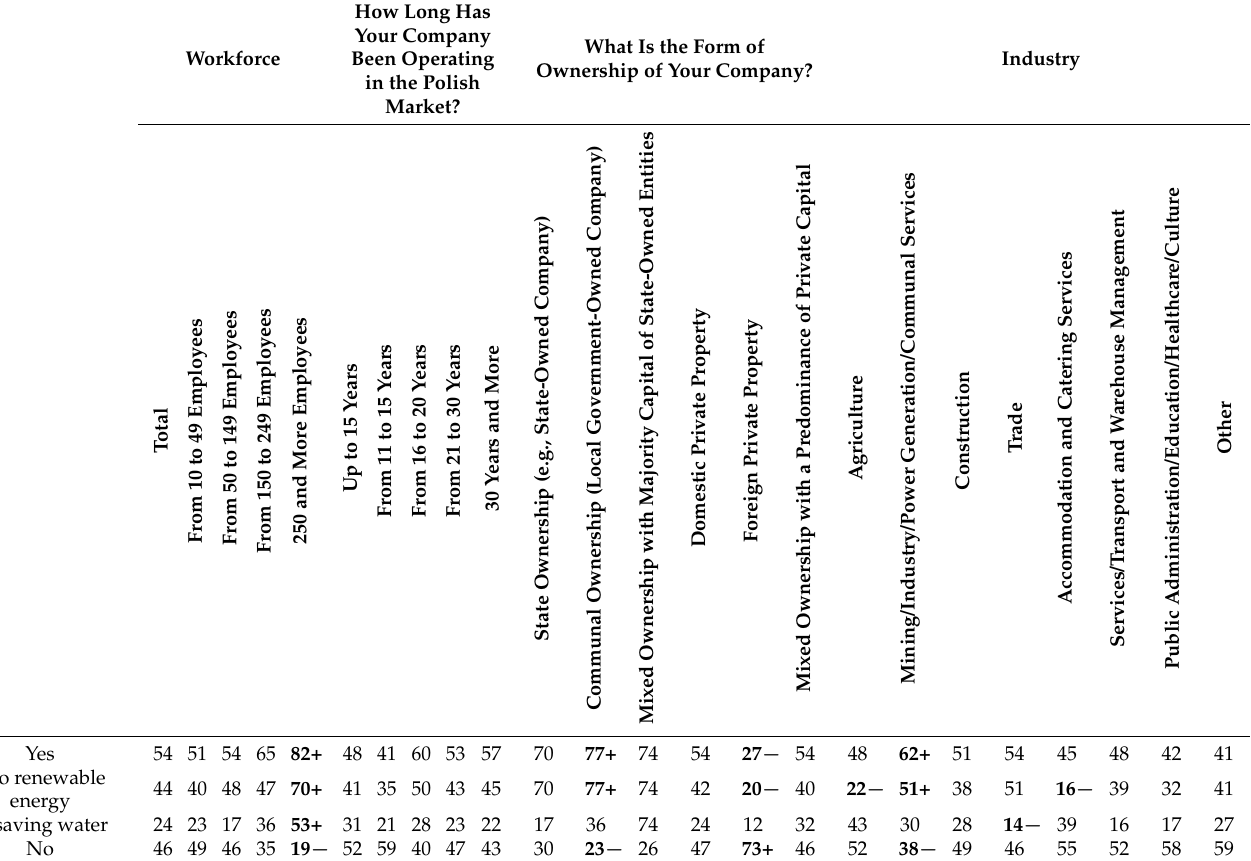
Table 6. Percentage of entrepreneurs investing or planning to invest in renewable energy or in water saving—by workforce, period of operation, form of ownership and industry. Does your company take or plan any measures to invest in renewable energy or to save